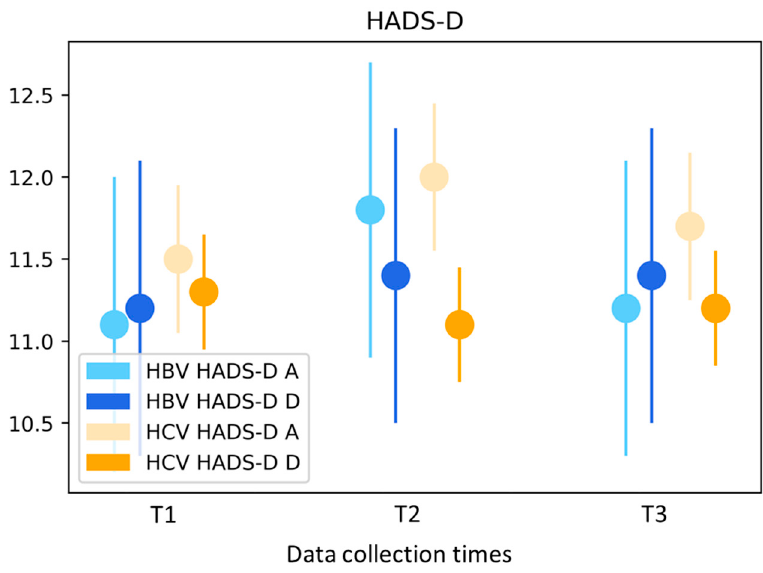
Figure 3. Hospital Anxiety and Depression Scale (HADS-D)—mean values stratified by type of hepatitis and adjusted for age and gender. HBV hepatitis B virus; HCV hepatitis C virus; HADS-D A Hospital Anxiety Scale; HADS-D D Hospital Depression Scale.